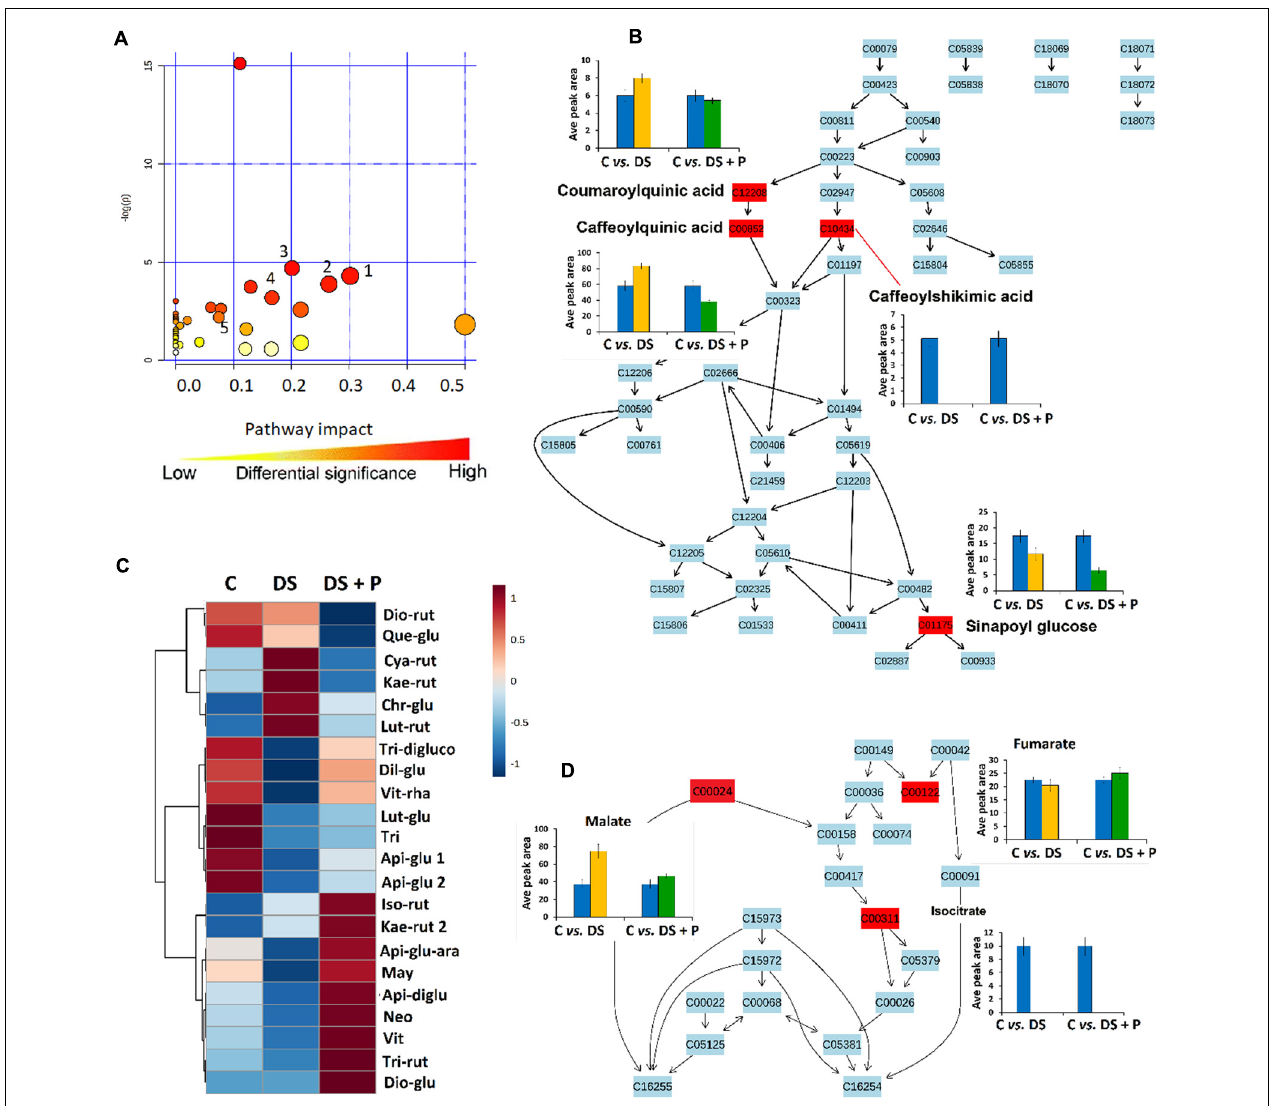
FIGURE 4 | A synopsis of metabolic pathway analysis generated using MetPA, and relative quantification of some altered phenolic compounds and TCA intermediates. (A) The graph displaying the “metabolome view” containing all the mapped pathways arranged by p -values on the y -axis and the pathway impact (differential significance) on the x -axis. Pathway impact values refer to the cumulative percentage from the matched metabolite nodes and the maximum importance of each pathway is 1. ( 1 ) Glycine, alanine and serine metabolism, ( 2 ) Ascorbate and aldarate metabolism ( 3 ) Tyrosine metabolism ( 4 ) Phenylpropanoid biosynthesis and ( 5 ) Citrate cycle (B) Topological characteristics of phenylpropanoid biosynthesis pathway, showing the quantification levels (averaged peak area) of the mapped metabolites. (C) A heatmap displaying differential quantitative alterations in the concentrations of the selected flavonoids (refer to Supplementary Table 1 for full names and p -values). (D) Topological characteristics of the citrate cycle pathway, showing the quantification levels of fumarate, malate and isocitrate under different conditions. C, control (no stress-no PGPR); DS, drought stress-no PGPR; DS + P, drought stress + PGPR